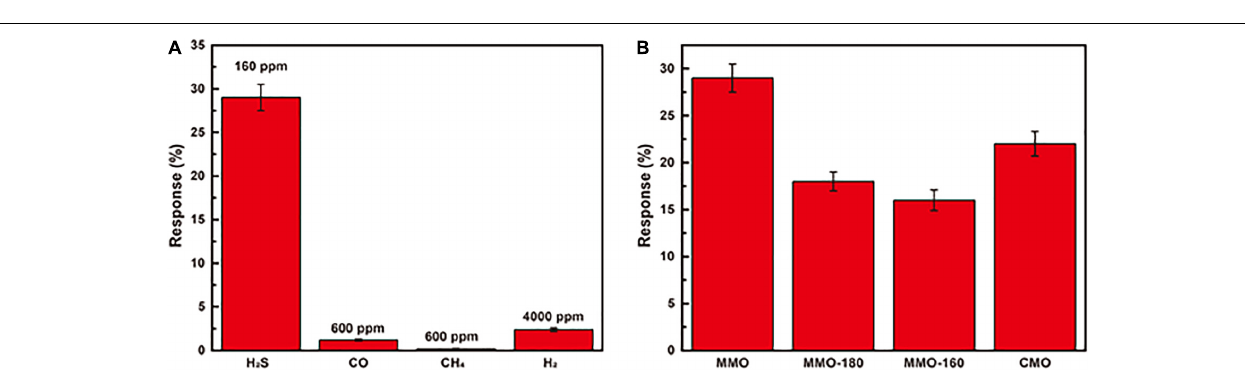
FIGURE 4 | (A) the response of MMOs to various gases; (B) the response of MMO, MMO-180, MMO-160, and CMO to 160 ppm H 2